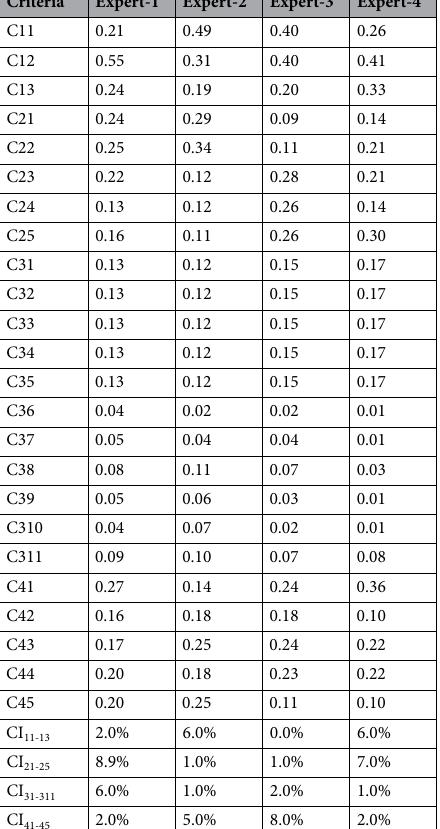
Table 3. Evaluation results of subjective judgements through